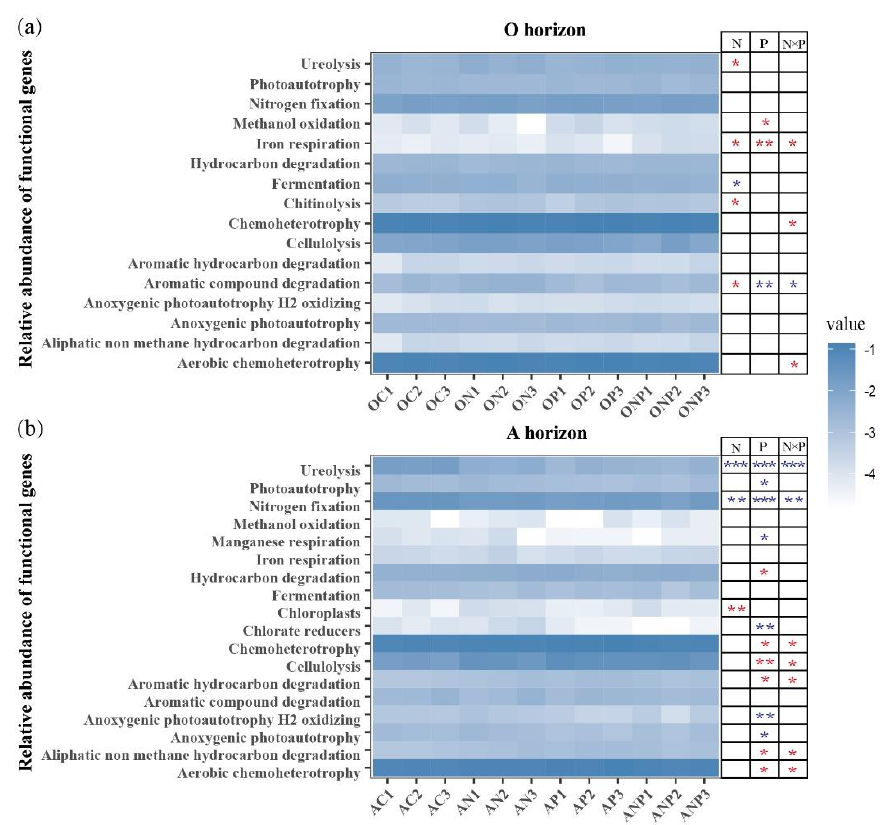
Figure 5. The relative abundance of putative bacterial functional categories under N and P additions based on the FAPROTAX database. N, P and N × P showed the effects of N, P and NP interaction on bacterial and fungal diversities, respectively (two-way ANOVA, * p < 0.05 ** p < 0.01 and *** p < 0.001). Red asterisks indicate positive effects and blue asterisks indicate negative effects. OC, ON, OP and ONP indicate the O horizon soils (0–5 cm, ( a )) under control (C, without N and P addition), N addition, P addition and NP addition, respectively. AC, AN, AP and ANP indicate the A horizon soils (5–15 cm, ( b )) under control (C, without N and P addition), N addition, P addition and NP addition, respectively.